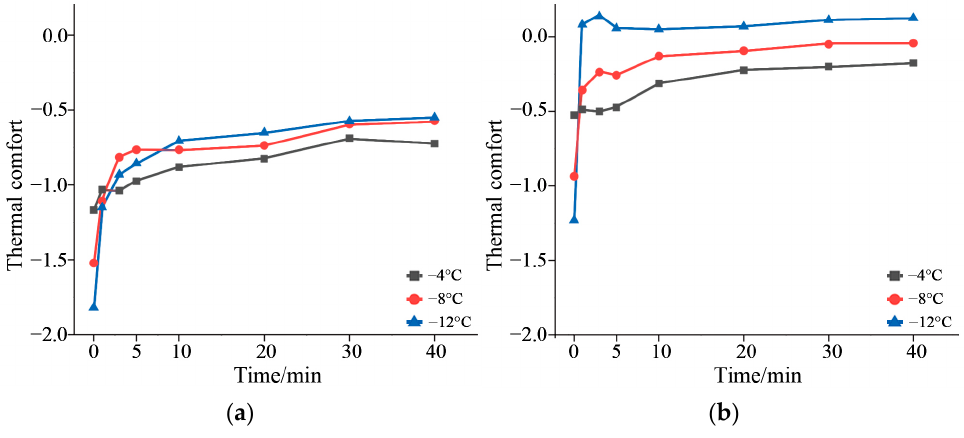
Figure 7. Thermal comfort. ( a ) Low activity; ( b ) high activity.